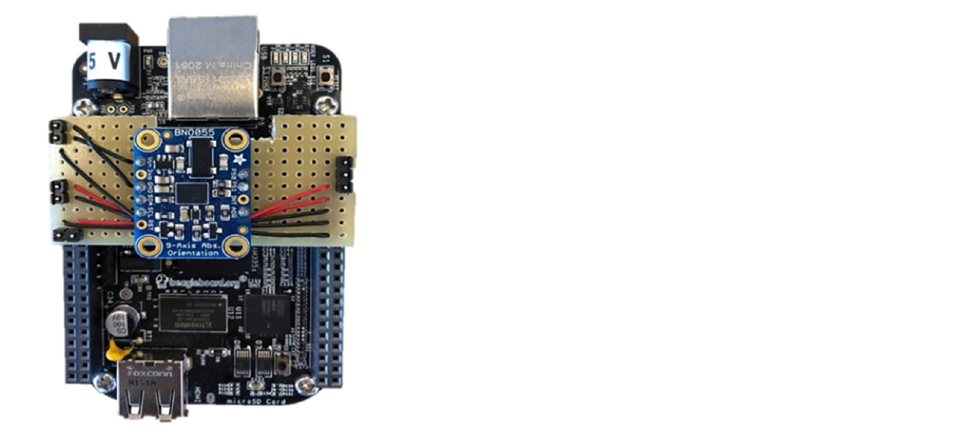
Figure 6. Used 6-DOF IMU with Magnetometer: model BNO055 from Bosch Sensortec